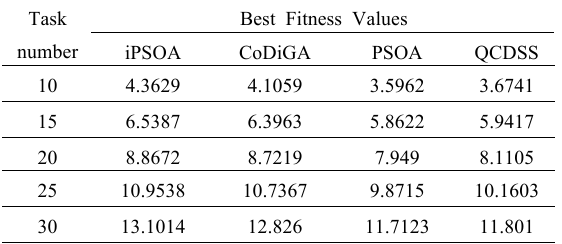
Table 2. Comparison of fitness values for different task